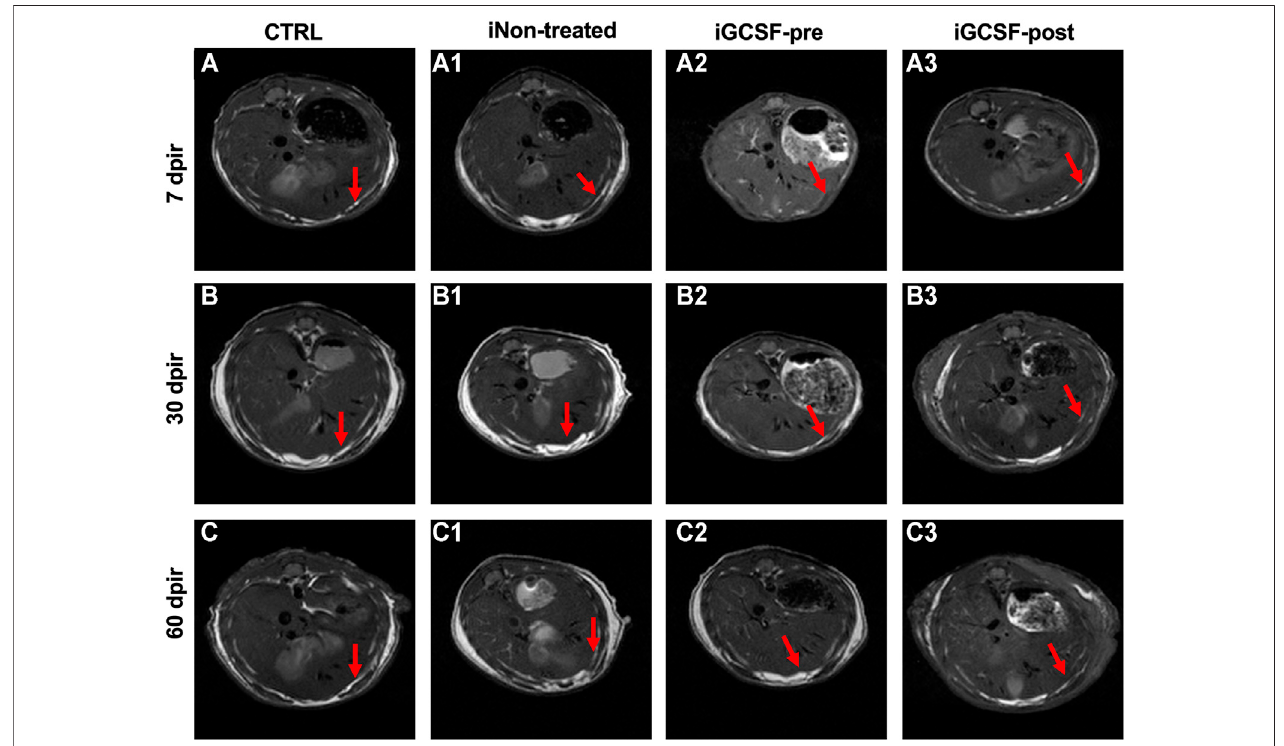
FIGURE 4 | Magnetic resonance image fi ndings. MRI images obtained from CTRL (A – C) , iNon-treated (A1 – C1) , iGCSF-pre (A2 – C2) and, iGCSF-post Group (A3 – C3) at 7, 30- and 60-day post-irradiation. Images obtained from CTRL Group (A – C) revealed liver parenchyma with diffusely homogeneous signal intensity and regular contours (indicated by arrows). Irregular contours (indicated by arrows) were observed in iNon-treated (A1 – C1) and, iGCSF-post Groups. In the iGCSF-pre Group, MR images suggest that the signal intensity was lower than in iNon-treated and iGCSF-post Groups, but it also showed irregular contours (indicated by arrows) (Panels A2 – C2) . All images were acquired before gadolinium intraperitoneal injection ( n (cid:1) 10 per